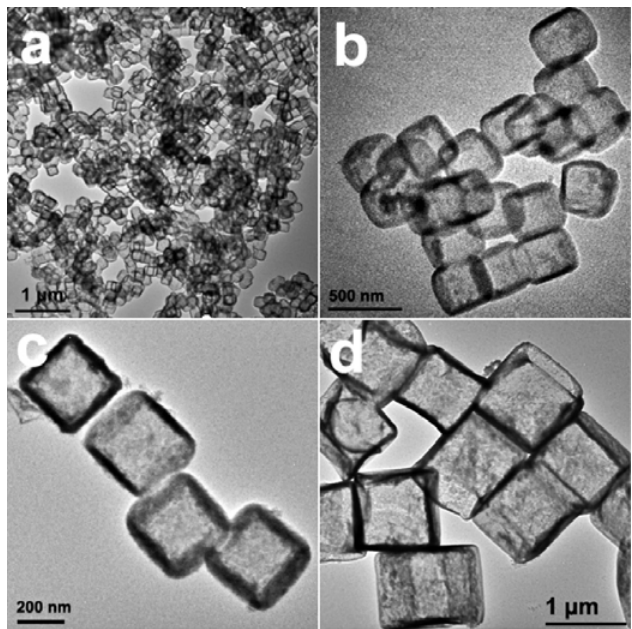
nanoboxes with different edge lengths: ( a – c ) 200–250 nm; Figure 6. TEM images of SnO 2 ( d ) 800–1000 nm. Adapted with permission from [58]. Copyright 2012 American Chemical